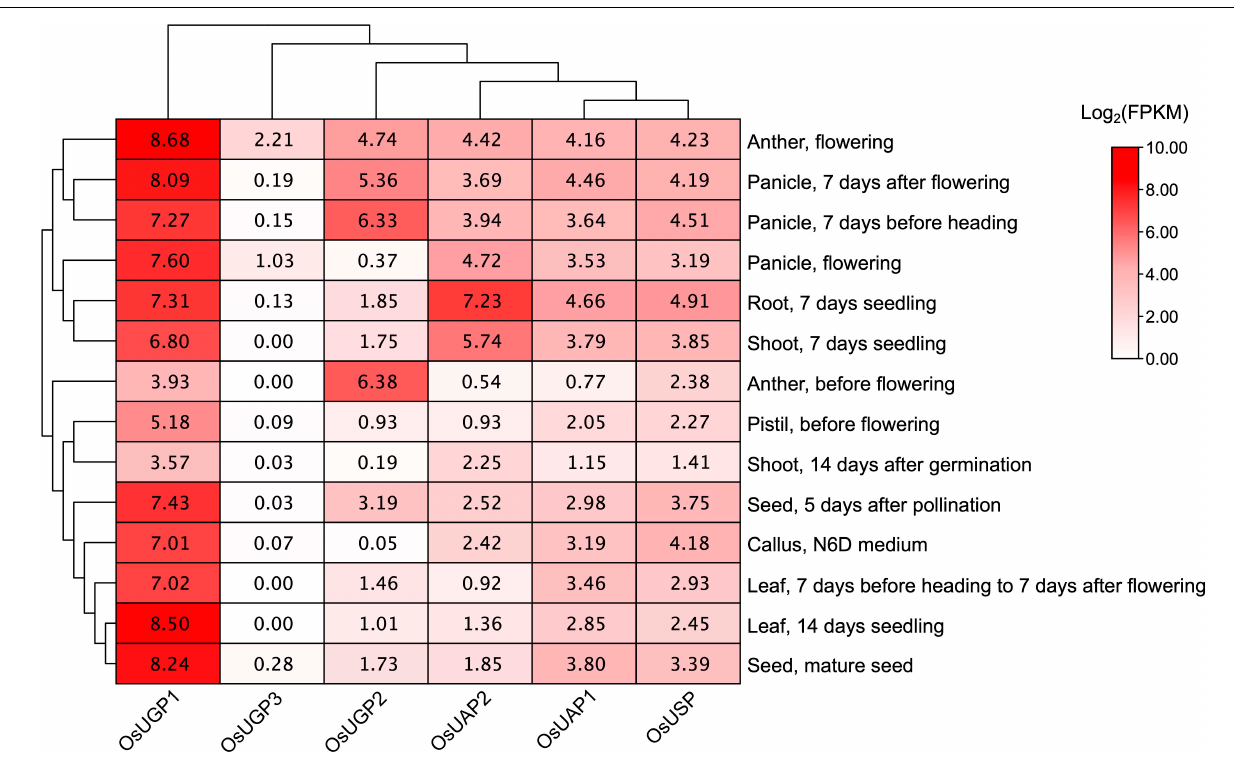
FIGURE 4 | UDP glucose pyrophosphorylase (UDPGP) expression profiles in different tissues from Oryza sativa . The RNA sequencing expression data of UDPGPs from different tissues and developmental stages in O. sativa were downloaded from the Rice Expression Database and displayed as filled blocks from white to